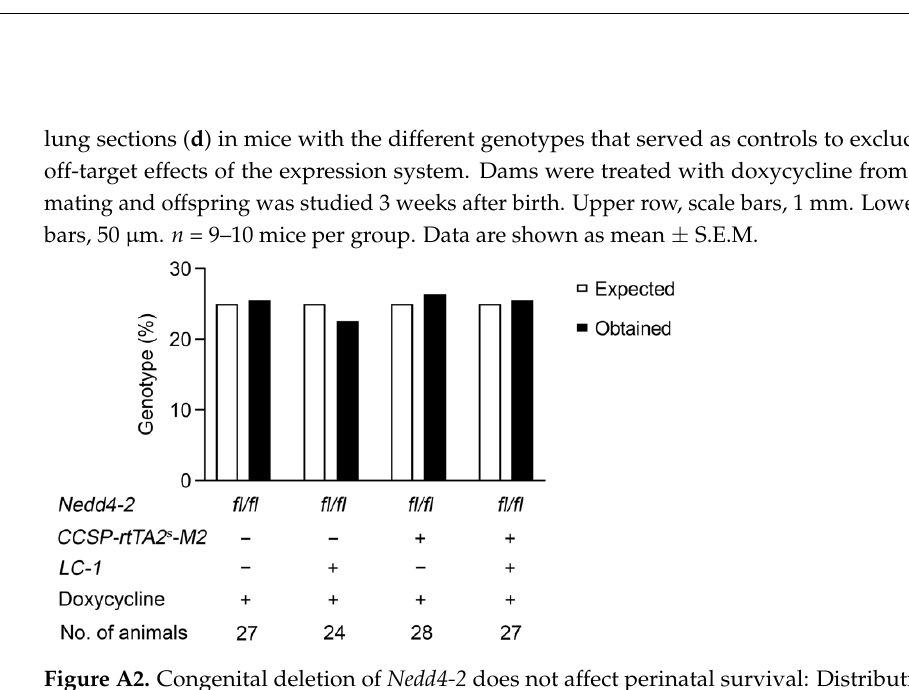
Figure A2. Congenital deletion of Nedd4-2 does not affect perinatal survival: Distribution of geno- types in 10-day-old mice from the intercross of doxycycline-induced Nedd4-2 fl/fl /CCSP-rtTA2S-M2 and Nedd4-2 fl/fl /LC1 mice. All genotypes are represented as expected from Mendelian ratios. n = 106 mice from 14 litters.